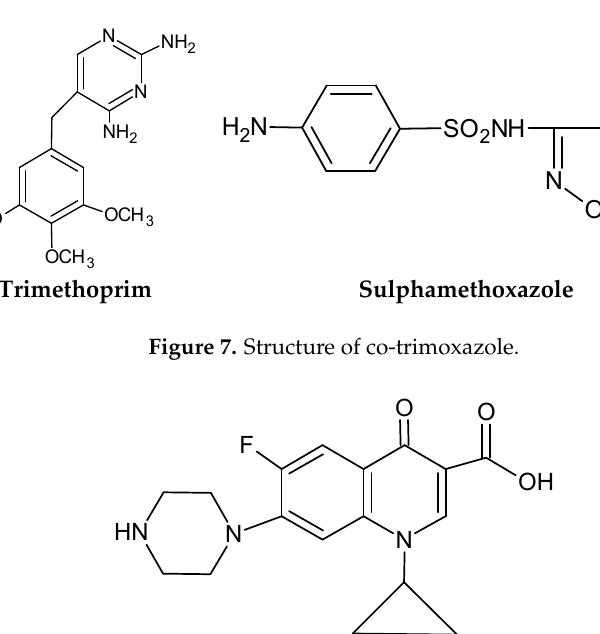
Figure 8. Structure of ciprofloxacin.